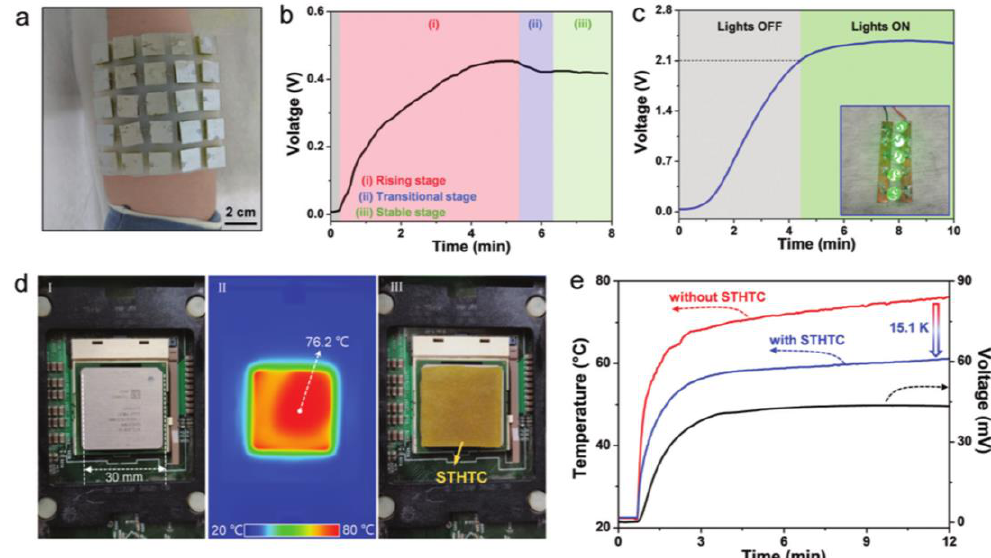
Figure 18. Practical applications of the STHTC. ( a , b ) The optical image of the 5 × 5 STHTC array device being fixed on an arm for harvesting human thermal energy ( a ) and corresponding voltage output ( b ). ( c ) The output voltage of the array device with the ice-box surface as the cold source and a square heating plate with a stable temperature of ~36.5 °C as the hot source for simulating human temperature, and the inset indicates that the produced electricity can directly light up five green LEDs. ( d ) The optical image of a normal working CPU (I) and corresponding infrared image with the maximum temperature of 76.2 ℃ (II), a STHTC placed on the surface of the CPU for device cooling and power generation (III). ( e ) The temperature curves of the CPU and corresponding output voltage, indicate the obvious temperature reduction of ~15.1 K when the CPU was covered with the STHTC. (Reproduced with permission from [123]. Copyright 2011 Royal Society of Chemistry).